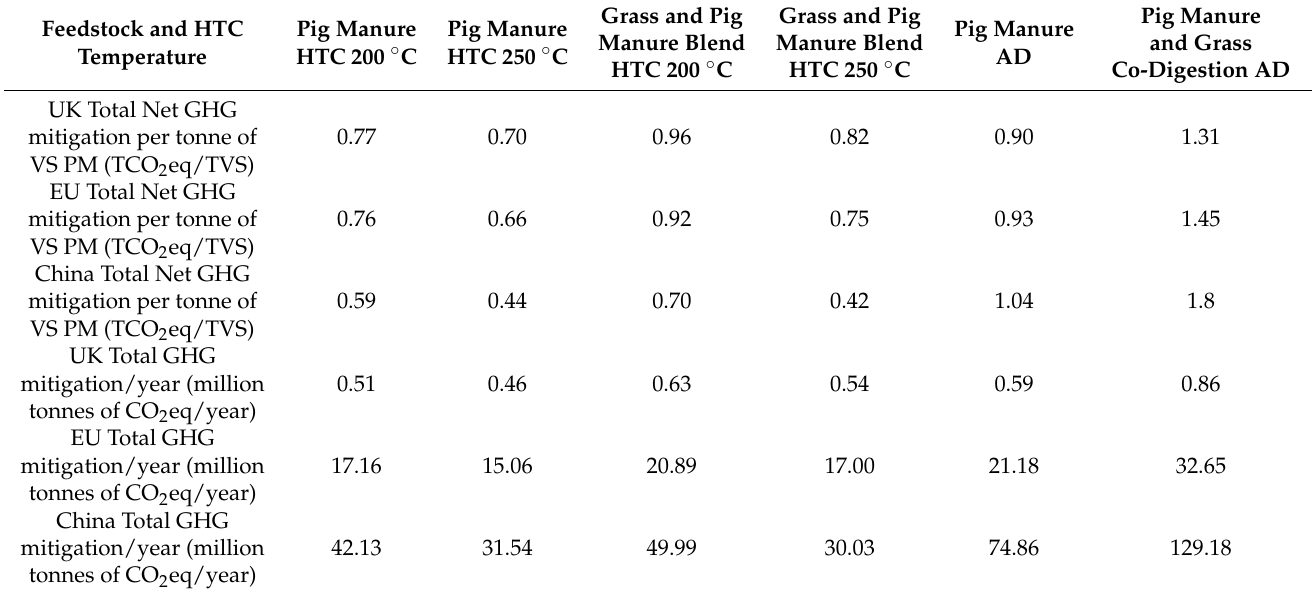
Table 8. Comparing total GHG mitigation from HTC and AD in the UK, EU, and